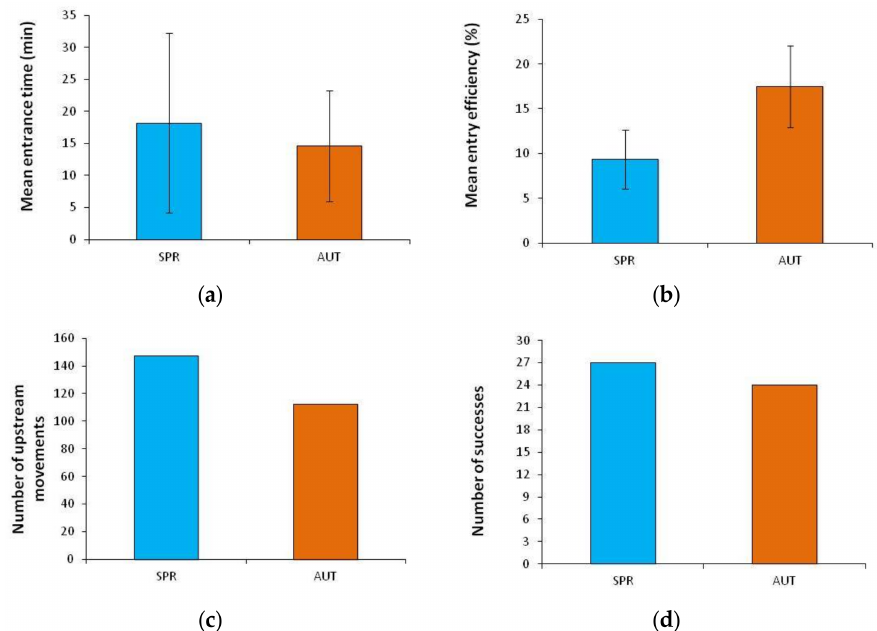
Figure 3. ( a ) Mean entrance time ± SD; ( b ) mean entry efficiency ± SD; ( c ) number of upstream movements; ( d ) number of successes performed by the I. barbel in both seasons (spring-SPR and early-autumn-AUT). Significant differences were found between seasons in the metric, “mean entry efficiency” ( p <